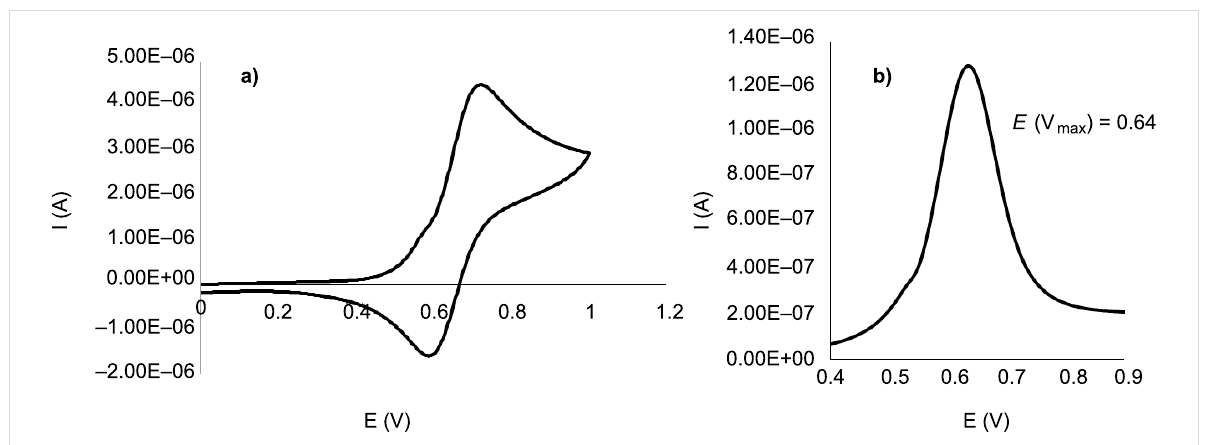
Figure 2: CV plot (a) and relevant DPV section (b) of complex 4 . Experiments were carried out using 1 mM solution of the complex in dry CH 2 Cl 2 with 0.1 M [NBu 4 ][PF 6 ] as the supporting electrolyte, 100 mVs − 1 scan rate, Fc + / Fc used as internal standard with E 1/2 (Fc/Fc + )= 0.44V vs SCE.